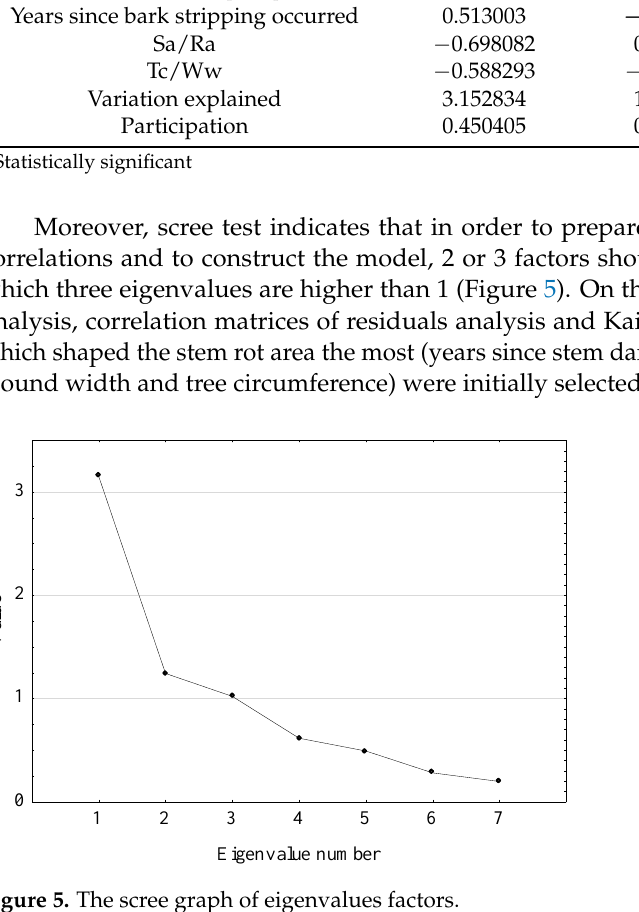
Figure 5. The scree graph of eigenvalues factors. Table 3. Intrinsic value.